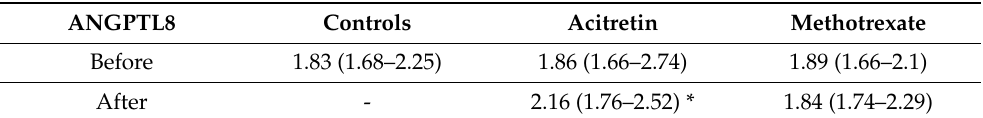
Table 4. Comparison between ANGPTL8 serum concentrations before and after treatment with ac- itretin and methotrexate separately in psoriatic patients, and in controls without psoriasis.